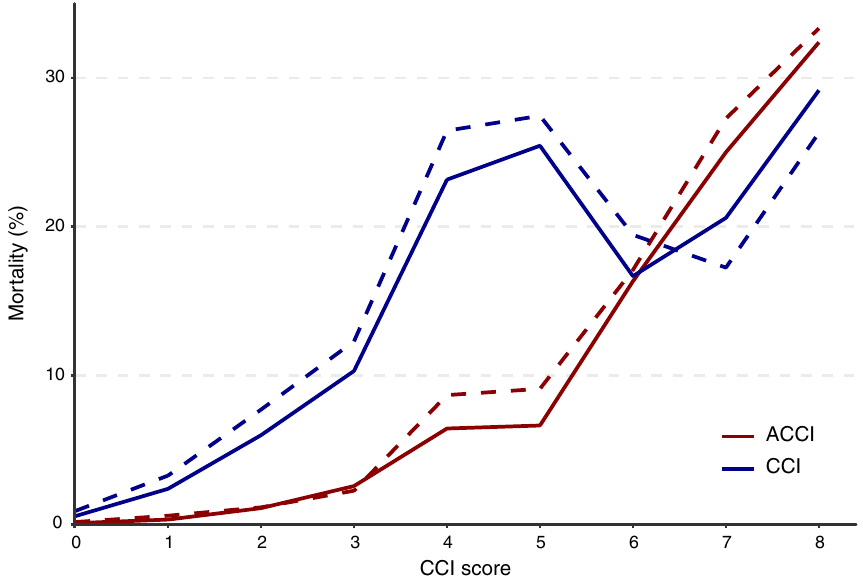
Figure 4. Mortality rate according to the Charlson comorbidity index (CCI) and age-adjusted CCI (ACCI) in the all-patient (solid line) and Daegu–Gyeongbuk cohorts (dotted